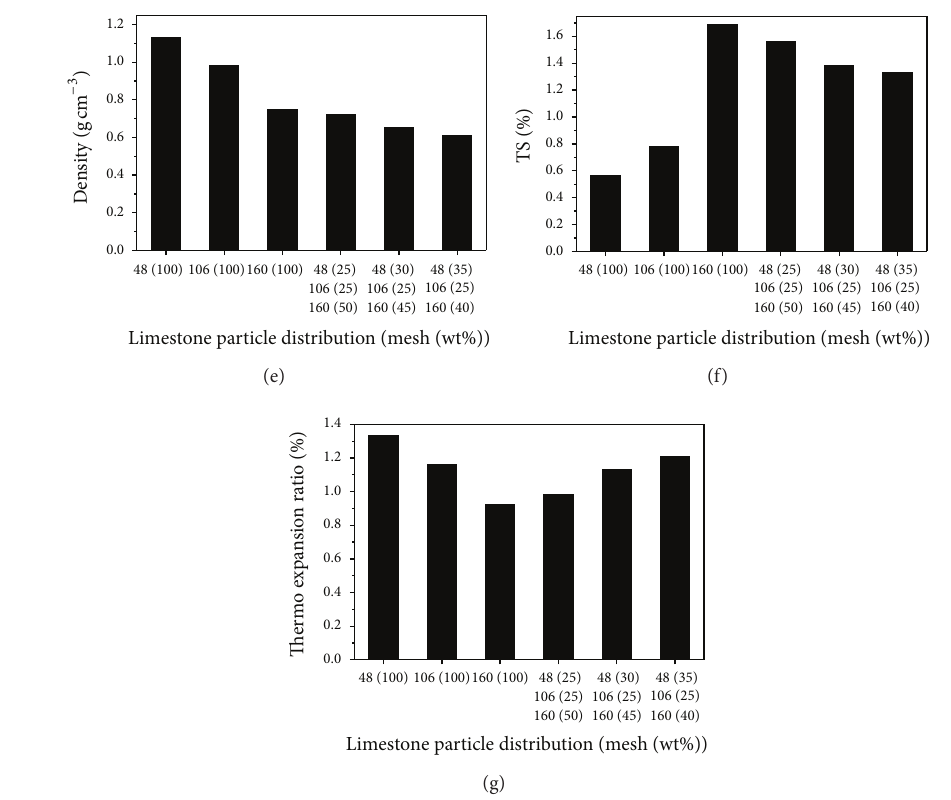
Figure 3: Effects of limestone particle size and size distribution on (a) MOR; (b) MOE; (c) IB; (d) shock strength; (e) density; (f) TS; and (g) thermo expansion